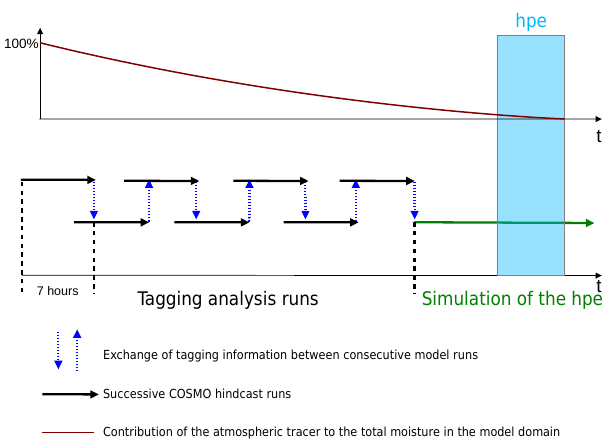
Figure 1. Schematic plot illustrating the concept of tagging anal- ysis. The heavy-precipitation event is denoted by hpe. The atmo- spheric tracer tags the moisture that is present in the atmosphere at the beginning of the